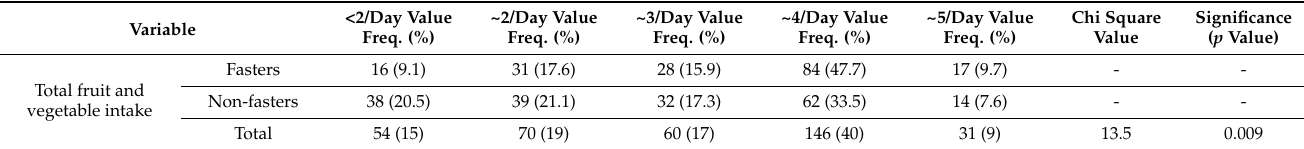
Figure 2. Bar chart for fruit and vegetable consumption between fasters and non-fasters.